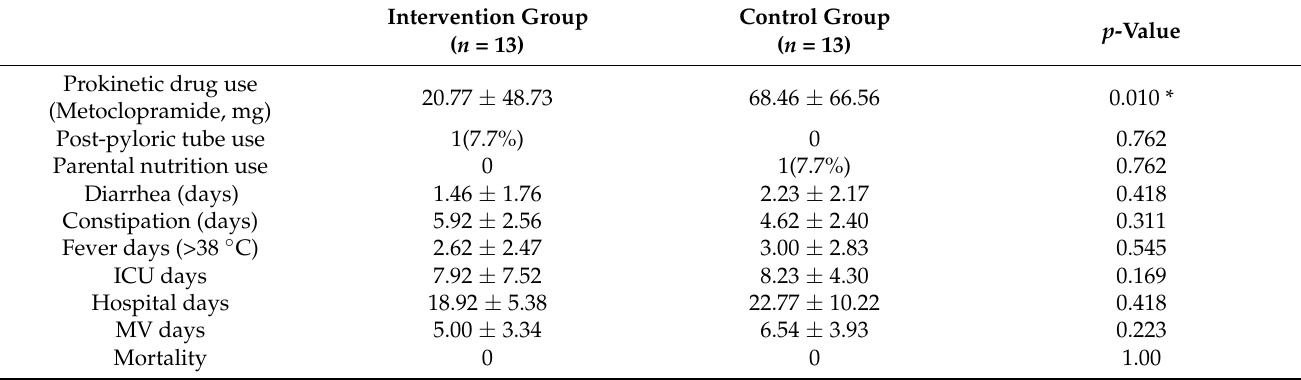
Figure 2. Repeat measures of EE percentages out of target EE over time. ( A ) This figure represents a visual description of a repeat measurements on days 4, 5 and 6 using a generalized linear model. Results are between groups p = 0.011 *, and between timelines p = 0.000 *. EE = energy expenditure. * refers to significant p -value levels lower to 0.05. ( B ) The observed tendency in reaching postoperative target EE over seven days. EE = energy expenditure. Table 2. Target EE (in kcal) and the duration required to achieve it in both groups. Table 3. Secondary outcomes revealed significantly less use of the prokinetics drug in the intervention